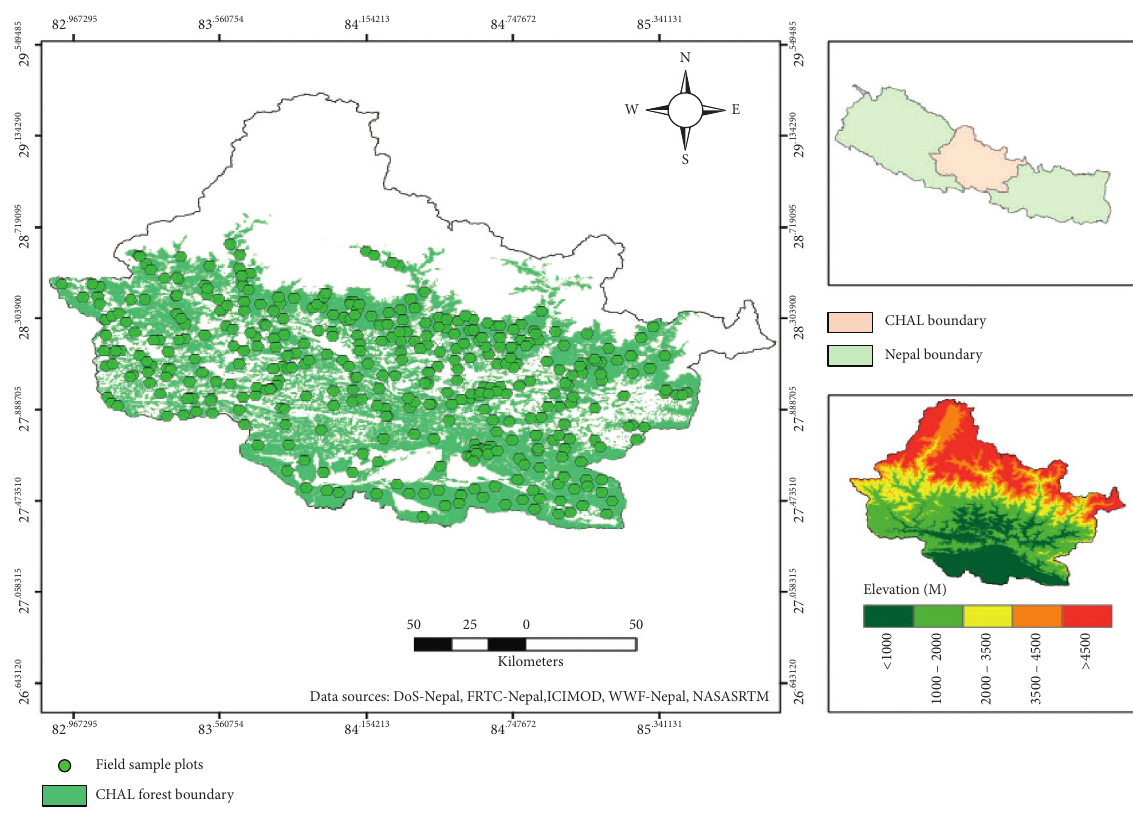
Figure 1: Map showing the study area with the field sample plot